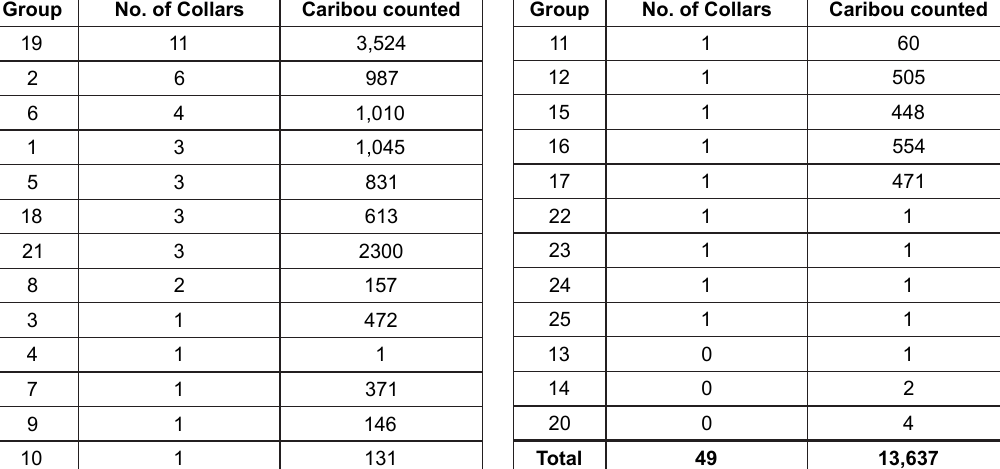
Model selection results indicated that a threshold model with groups of 3 or more having a sight-